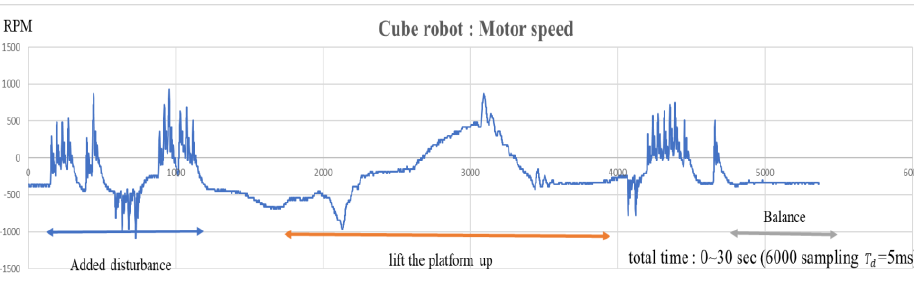
. θ P of the cube robot balancing on its edge.